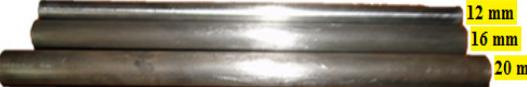
Fig. 5. Steel Dowel Bars.